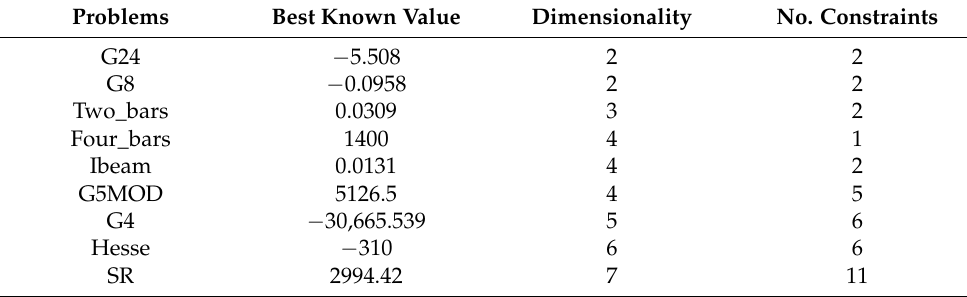
Table 1. Constrained optimization benchmark